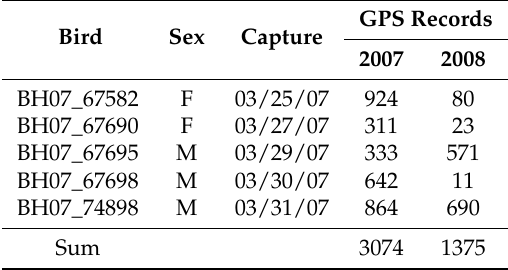
Table 1. ID number, sex, capture time, and number of GPS locations of five selected Bar-headed Geese.